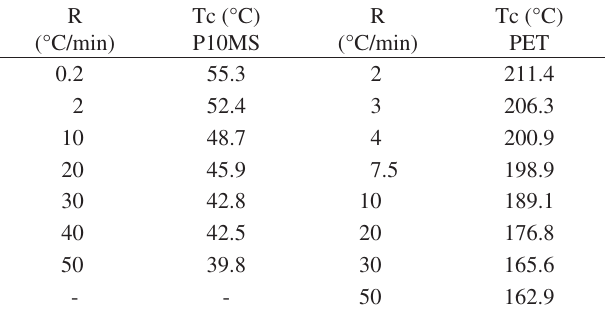
Table 3. Crystallization temperature as a function of cooling rate for P10MS 3 and PET 7 .